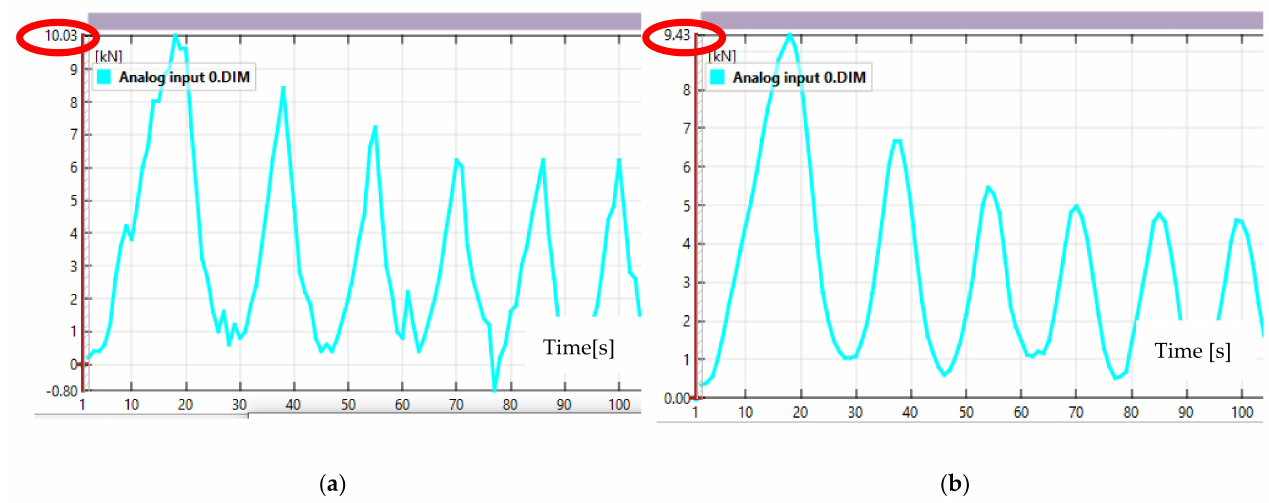
Figure 7. Force values read from analog input 0 source: ( a ) without applying filters; ( b ) after applying a temporary filter with a value of